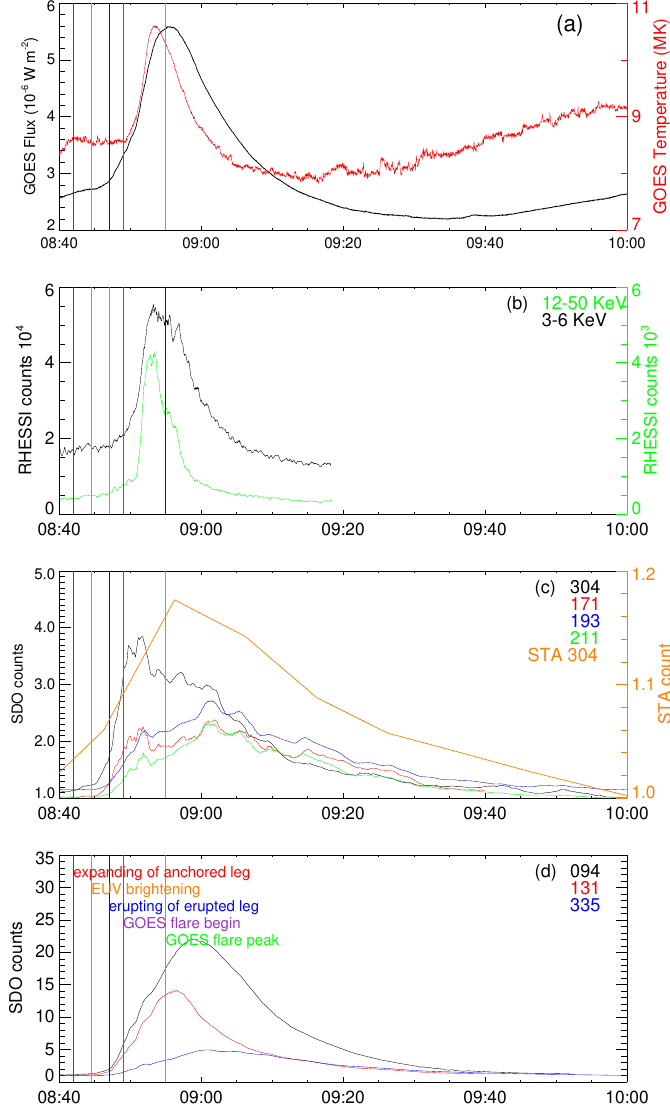
Figure 4. ( a ) GOES X-ray intensity profile at wavelength of 1–8 Å (black curve) and temperature profile deduced from GOES flux (red curve); ( b ) RHESSI time profile at 3–6, 12–50 KeV; ( c ) SDO/AIA EUV light curve in cool line of 304, 171, 193 and 211 Å; ( d ) SDO/AIA EUV light curve in hot line of 335, 094, and 131 Å; the five vertical lines indicate the following time: 1. expansion of the anchored leg; 2. appearance of the initial EUV brightening; 3. erupting of the erupted leg; 4. GOES flare begin; 5. GOES flare